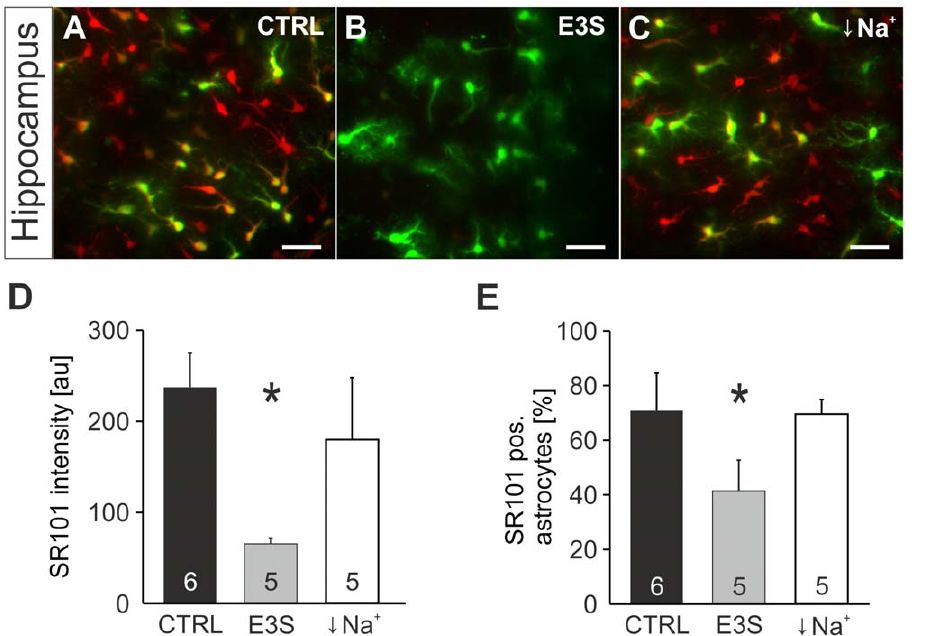
Figure 10. Effects of Estrone-3-Sulfate and Na + -free solution on SR101-uptake by astrocytes. A: Overlay of astroglial EGFP- fluorescence (green) and SR101-fluorescence (red) in the hippocampus after a staining in CTRL conditions. B: Overlay of EGFP- and SR101-fluorescence after application Estrone-3-Sulfate (E3S, 100 m M) in the staining solution shows significant reduction of SR101-fluorescence intensity. C: Overlay of EGFP- and SR101-fluorescence in the hippocampus after staining in Na + -free solution shows no Na + -dependence of SR101-uptake. Scale bars: 40 m m. D: the statistical comparison confirms significant reduction of SR101-labeling by E3S in the hippocampus, but no effect of Na + -free solution. ( E ) Statistical comparison of the effects of E3S and Na + -free solution on the percentage of SR101-labeled astrocytes in the hippocampus.